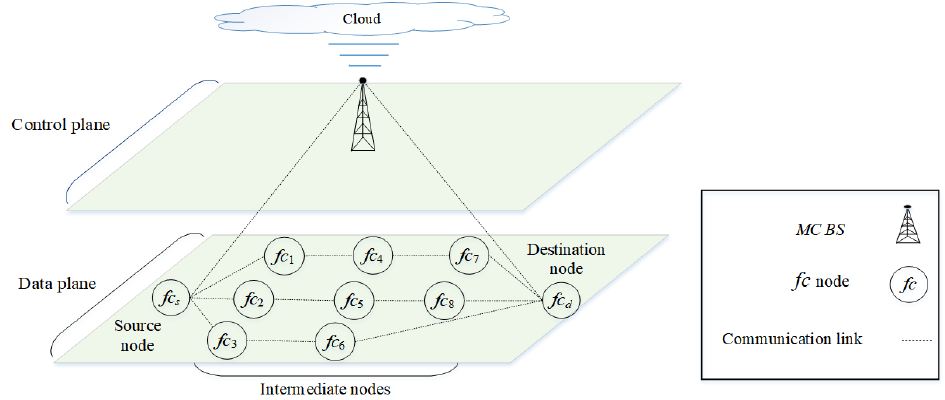
Figure 2. Control and data plane separation in a multi-tiered 5G network. An equivalent network is shown in Figure